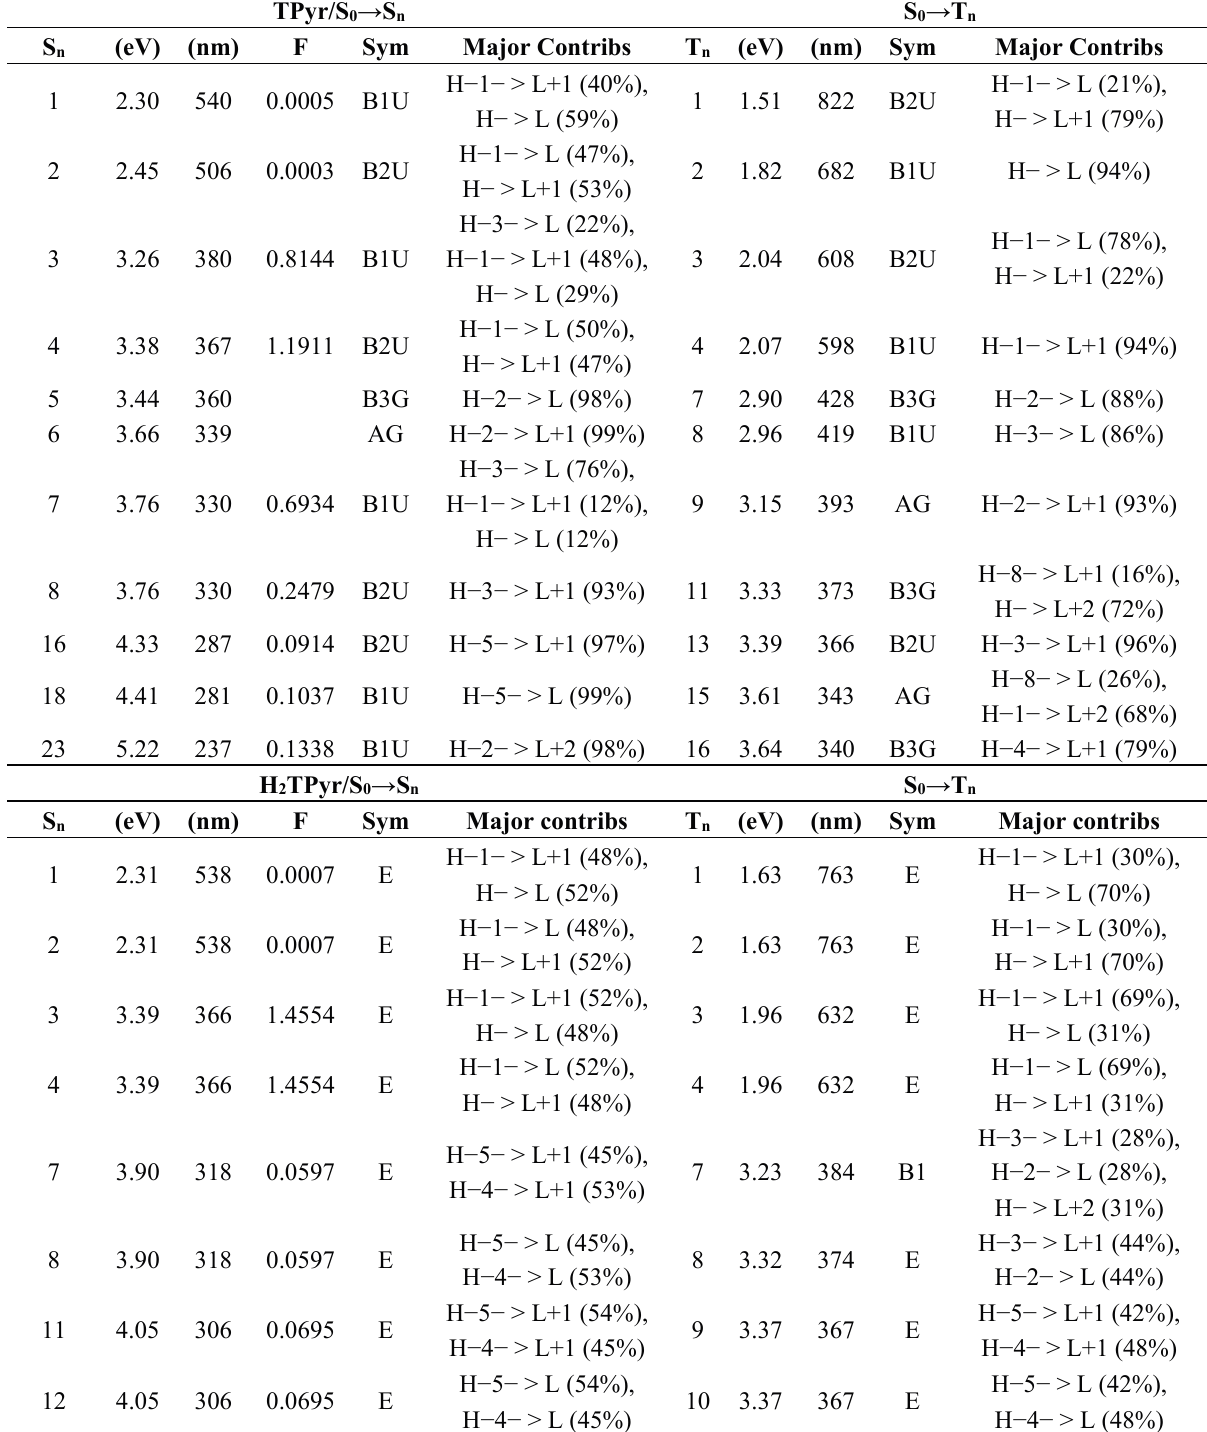
Table 5. The selected values of the calculated singlet-singlet ( S → T ) vertical electronic transitions for the TPyr, H 2 TPyr, TPP, H 2 TPP, TSPP, H 2 TSPP, ( S 0 n and H 6 TSPP (in water used as a solvent) at TD-B3LYP/6-31G(d,p) level of the TD-DFT. The percentages in the parenthesis indicate the contributions from the different HOMO(H) → LUMO(L) transitions to a desired electronic transitions and the minor contributions are not provided